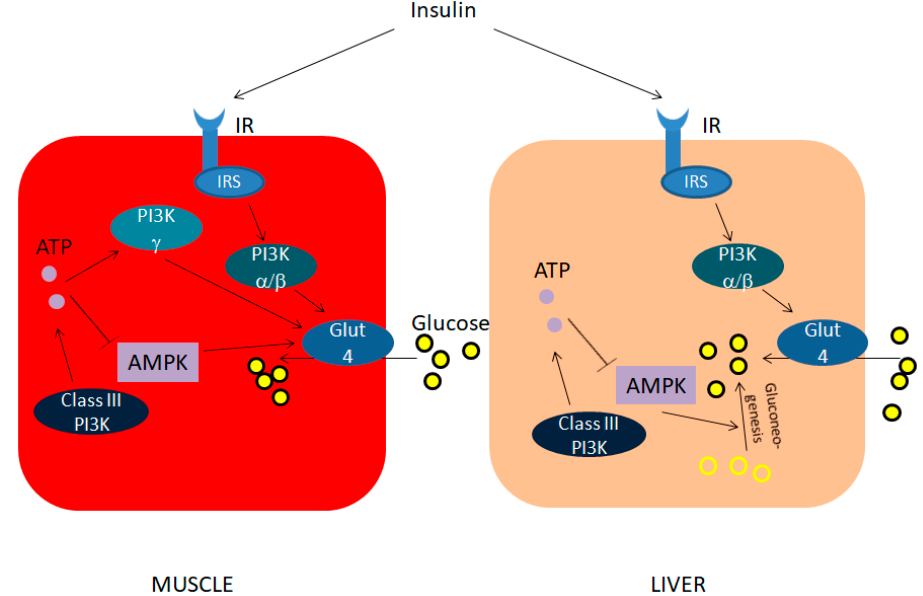
Figure 2. Main effects of PI3Ks on glucose homeostasis in muscle and liver cells. IR, Insulin Receptor. IRS, Insulin Receptor Substrate. ATP, Adenosine Triphosphate. AMPK, Adenosine Monophosphate Kinase. → Activation, Inhibition.